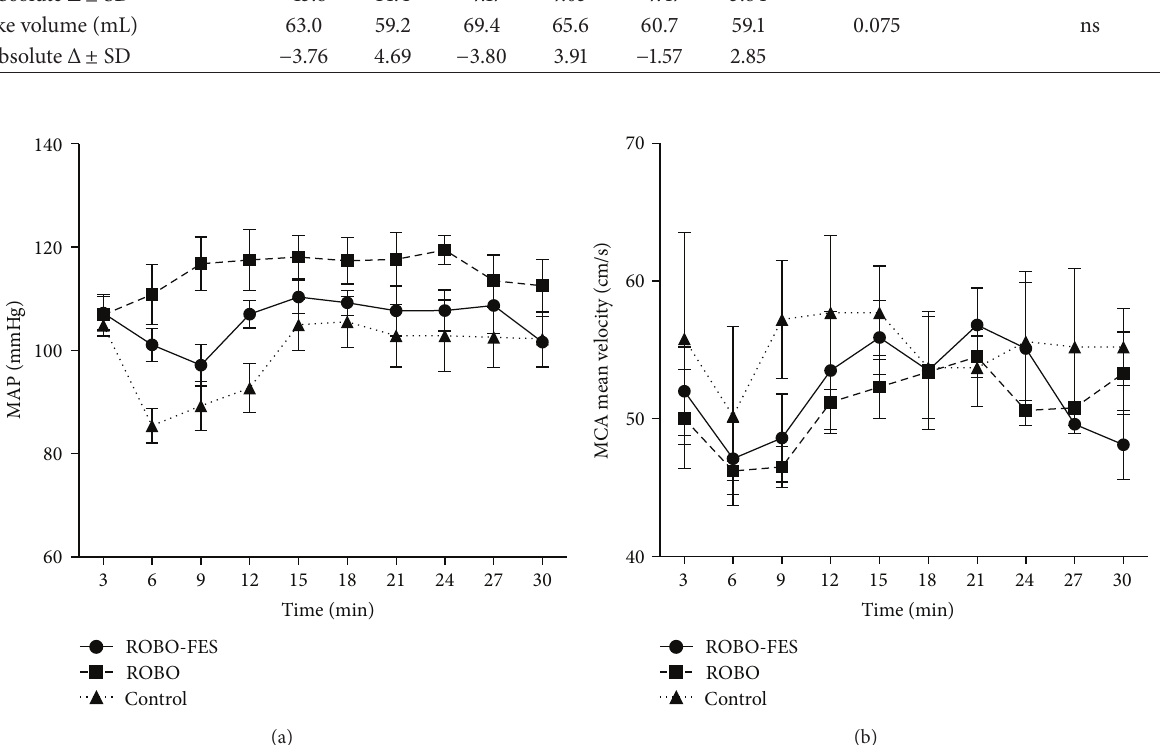
Figure 6: Intrasession evolution of mean arterial pressure (MAP) and mean cerebral blood flow velocity (CBFV) in the MCA of the affected hemisphere during training session 1 (values are averaged in 3 min-time windows). (a) MAP shows an initial dip in control and ROBO-FES groups during the first 9 min of training and returned to baseline thereafter. (b) Similarly, mean CBFV only decreased in the first 6–9min and then quickly returned to baseline. Error bars indicate